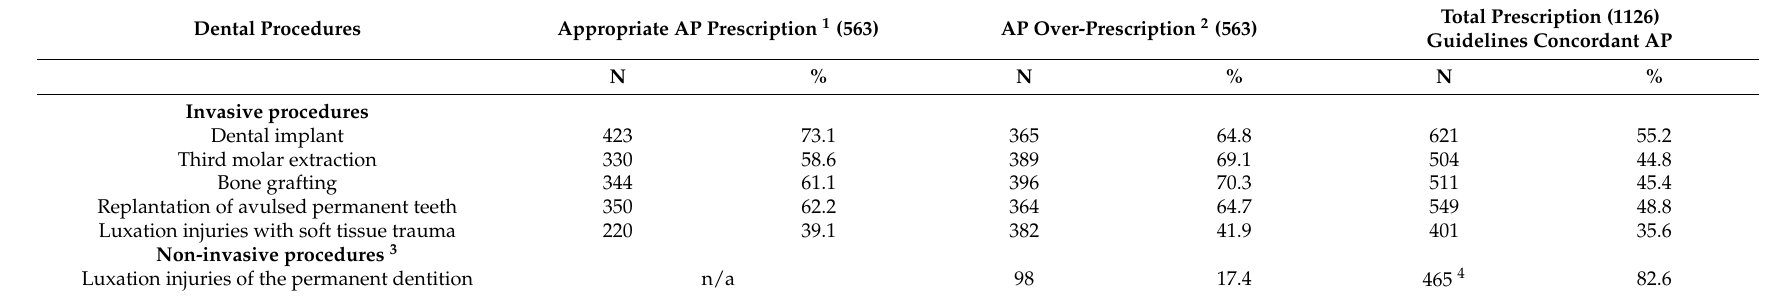
Table 1. Self-reported AP prescription in the explored dental procedures according to presence of an